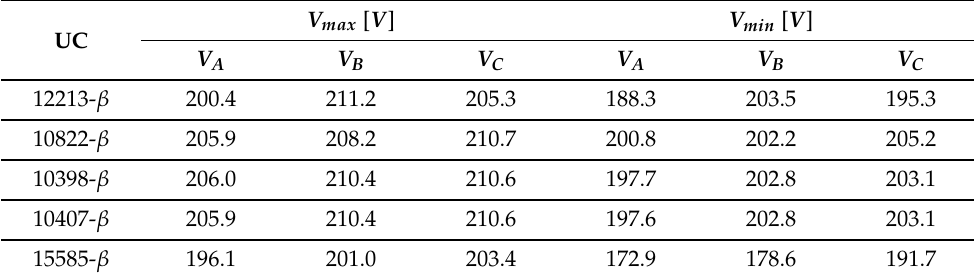
Table 10. feeder- β maximum and minimum voltage with pf =